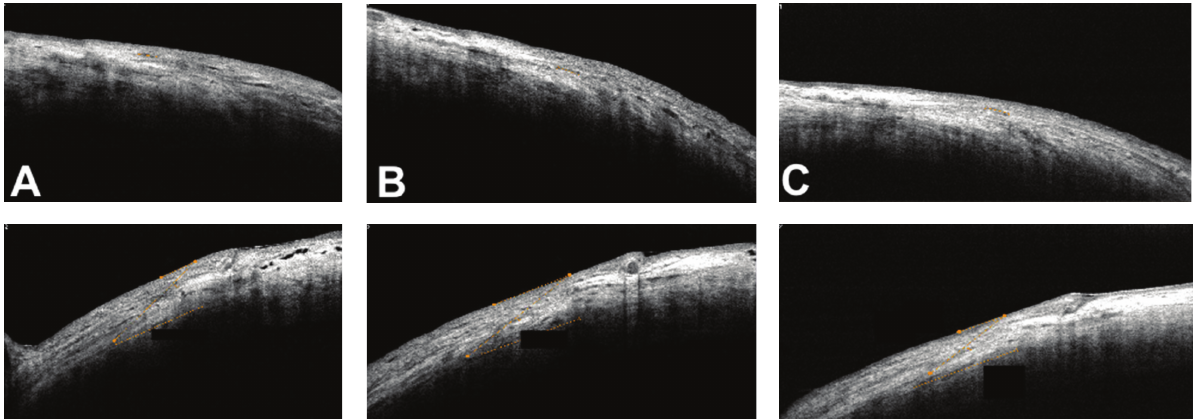
Figure 2: Spectral domain OCT images (RTVue with a corneal adaptor module-CAM from Optovue Inc., Fremont, CA) at the postoperative period of 23-gauge sutureless pars plana vitrectomy. (A) Longitudinal (upper) and transversal (bottom) length measurement at the sclerotomy incision, on postoperative day 1. (B) Longitudinal (upper) and transversal (bottom) length measurement at the sclerotomy incision, on postoperative day 7. (C) Longitudinal (upper) and transversal (bottom) length measurement at the sclerotomy incision, on postoperative day 30.